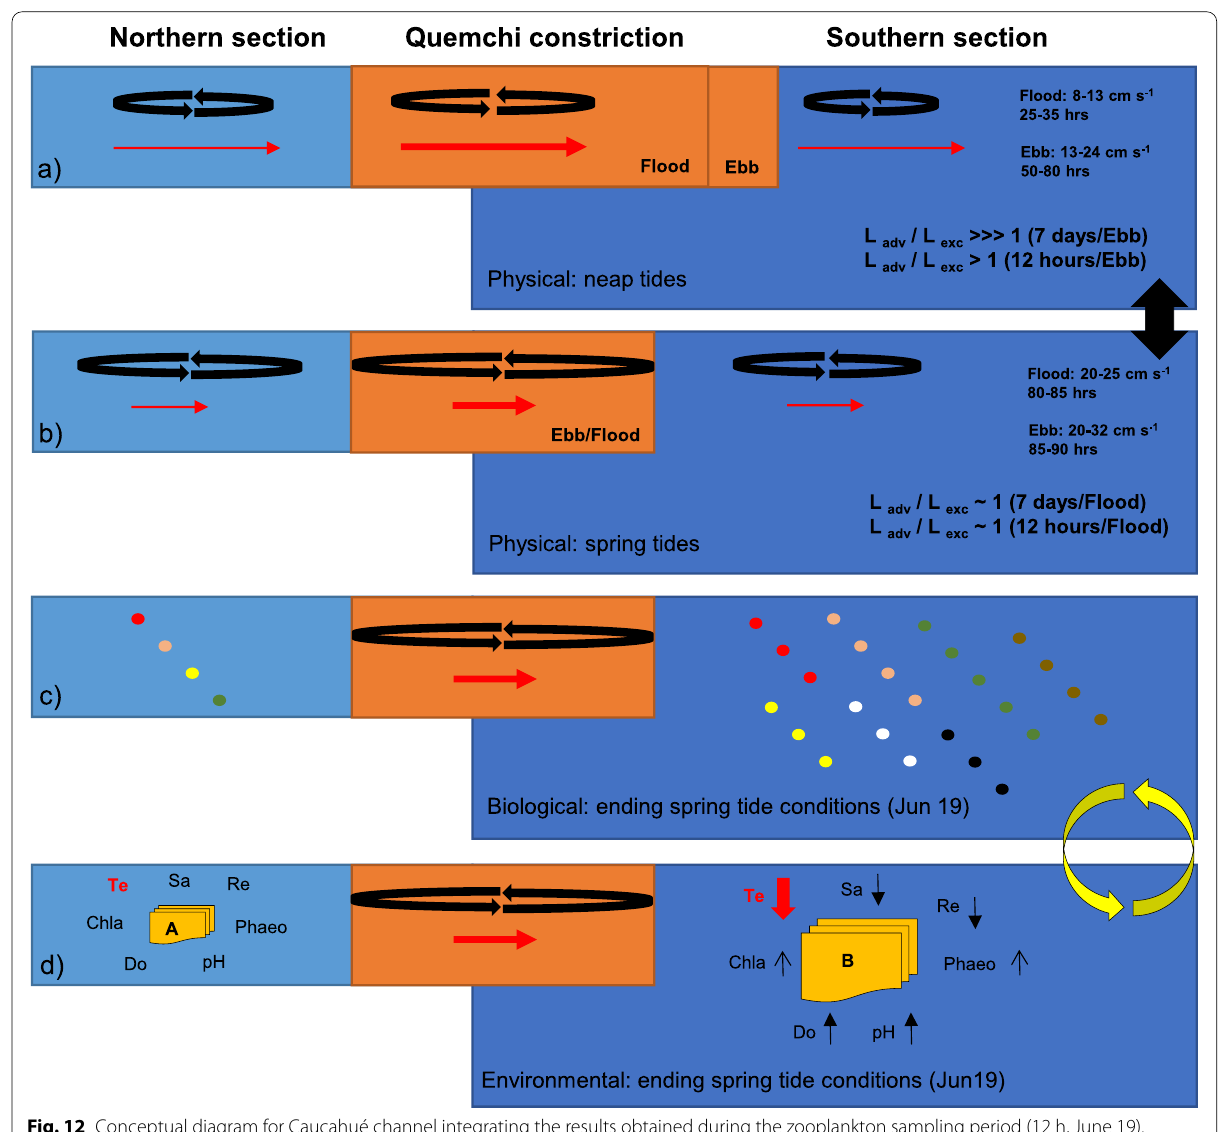
Fig. 12 Conceptual diagram for Caucahué channel integrating the results obtained during the zooplankton sampling period (12 h, June 19). Black arrows counterclockwise tidal excursion. Red arrows: southward residual flow. a and b show the ratios L adv and L exc estimated according to = Sobarzo et al. (2018) [20], indicating the net southward transport between the sections of the channel and also the speed recorded for the ebb and flood phases in the neap and spring fortnightly periods estimated in this study. Color circles in ( c ) represent conceptually the different species of the zooplankton community and their relative abundances. Yellow arrows indicate the biological‑environmental relationships in the water column. d shows the studied environmental variables in both sections of the Caucahué channel and how they differ on June 19, indicated by the direction of the arrow (see also DistLM